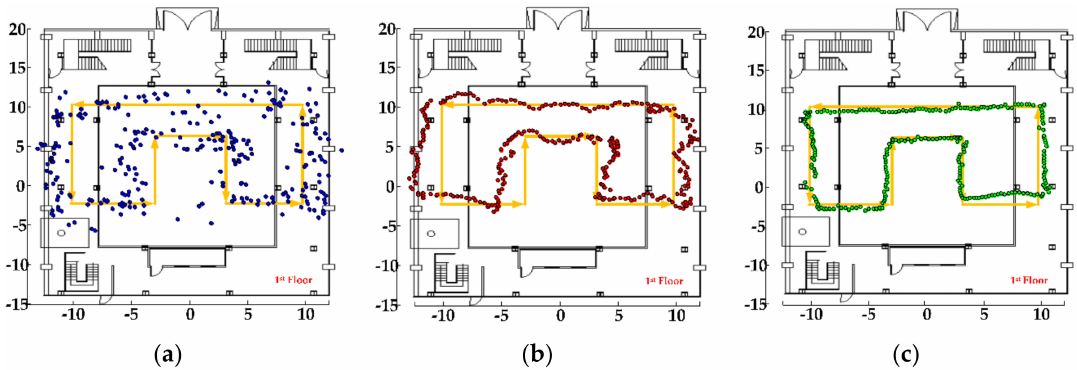
Figure 12. Positioning results in test environment 1: ( a ) CNN fingerprint positioning results, ( b ) particle filter (PF) fusion positioning results, and ( c ) PF fusion microelectromechanical systems (MEMS) + MAP positioning